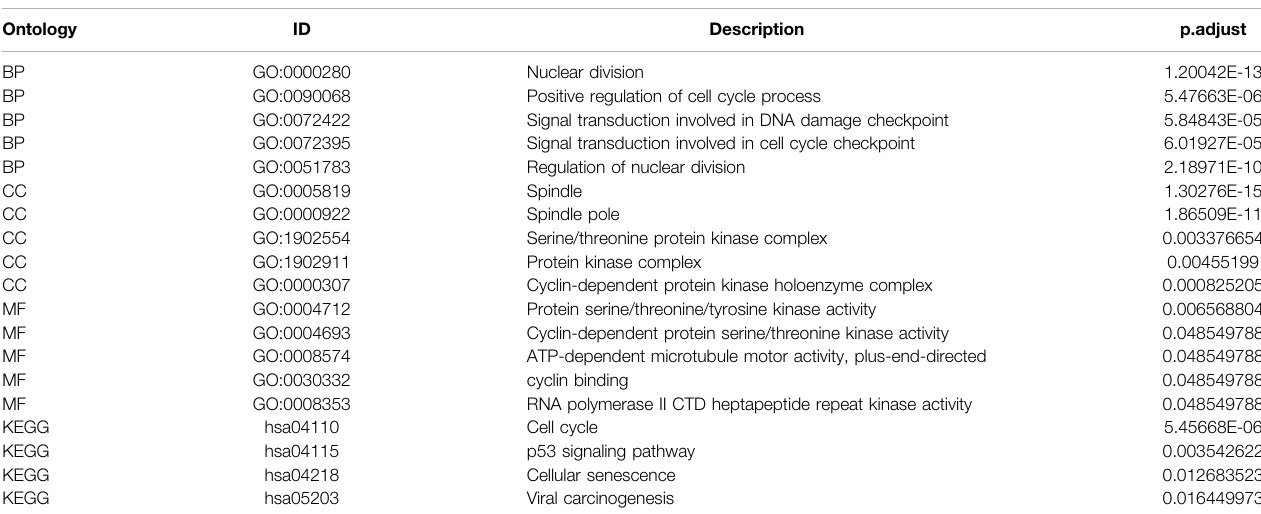
TABLE 3 | The overview of KEGG pathways and GO enrichment terms selected. Ontology ID Description